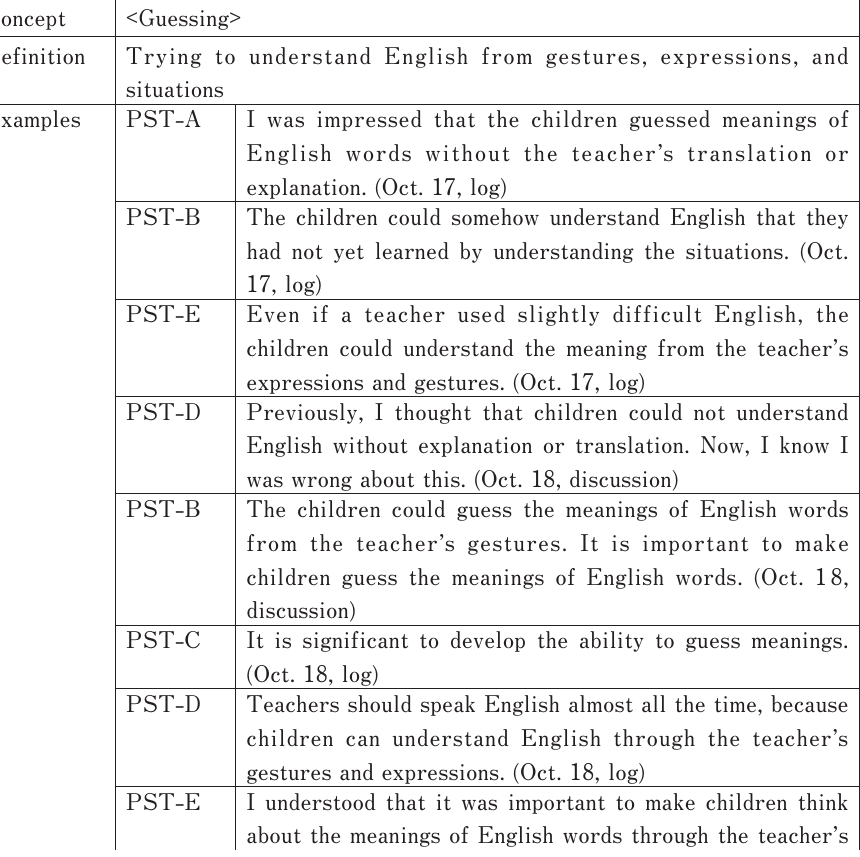
Table 1 Analysis Worksheet of